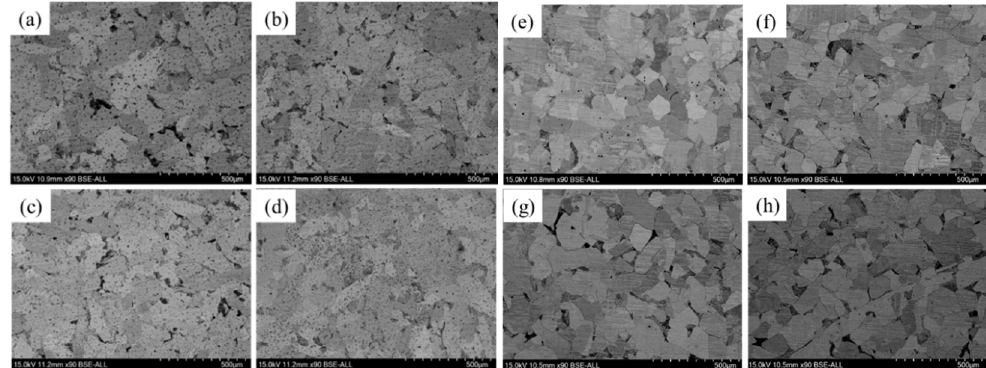
Figure 10. Comparison of room-temperature structure appearance of slab: ( a – d ) before magnesium treatment; ( e – h ) after magnesium treatment.